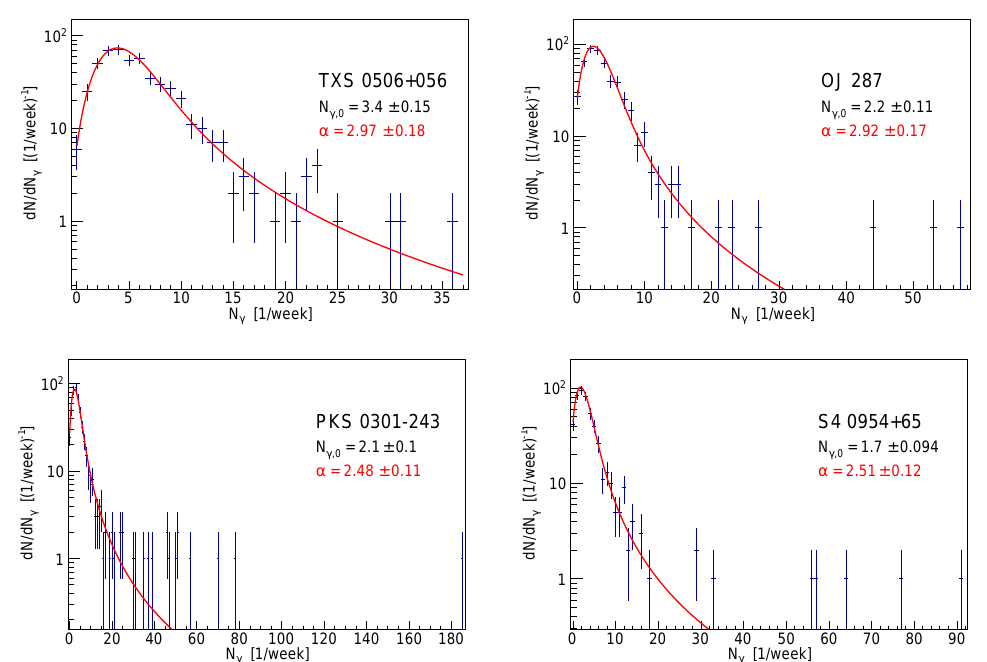
Figure 1. Histogram of the number of photons, N γ , detected per week by the FAVA analysis in the direction of TXS 0506 + 056, OJ287, PKS0301-243, and S40954 + 65 in the high-energy bin (800 MeV − 300 GeV). The photon distribution is modelled as a power law with spectral index α convolved with a Poissonian distribution (solid red line). Table 1. Flare duty factor, f fl , and fraction of energy released during flares, b fl , for a sample of sources as derived from the FAVA analysis. We report values for the low-energy, LE , 100 − 800 MeV, and high-energy, HE , 800 MeV − 300 GeV, bins. The duty factors quoted are for flux enhancement ≥ 5 σ according to the FAVA definition. The γ -ray luminosity of the sources, L γ (in units of erg s − 1 ), is derived from the 3FGL in the 1 − 100 GeV energy range. Rounded values of the power-law index, α , are also